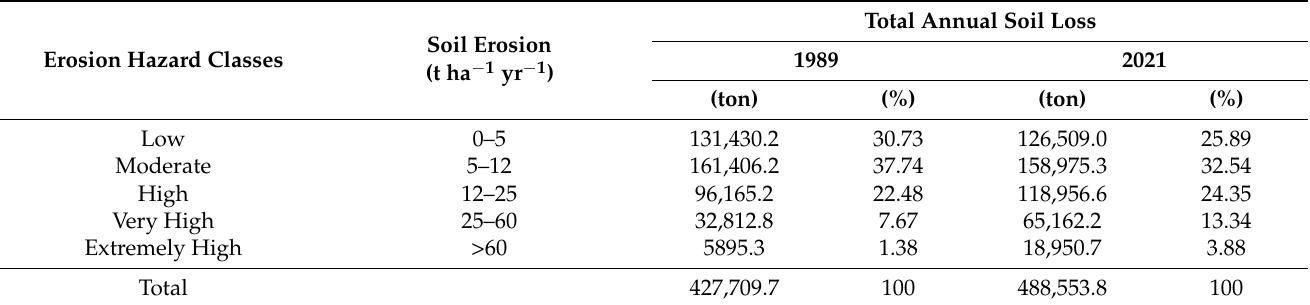
Table 10. Total soil loss and corresponding erosion hazard classes in MORB from 1989 to 2021.